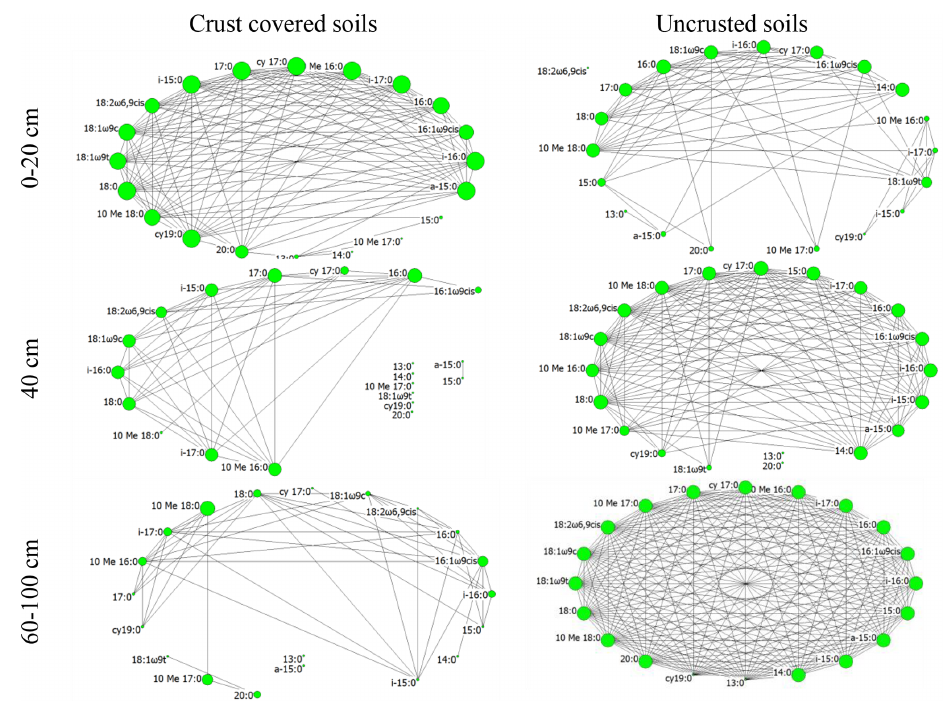
Figure 3. Network of interactions among the members of the soil microbial community (various PLFA biomarkers) under two crust coverage regimes, along a straight line of 100cm at successive distances from the trunk to the periphery of Erica spp. shrubs. The size of each node represents its eigenvector centrality; the larger the node the higher the eigenvector centrality and the higher the influence of the corresponding